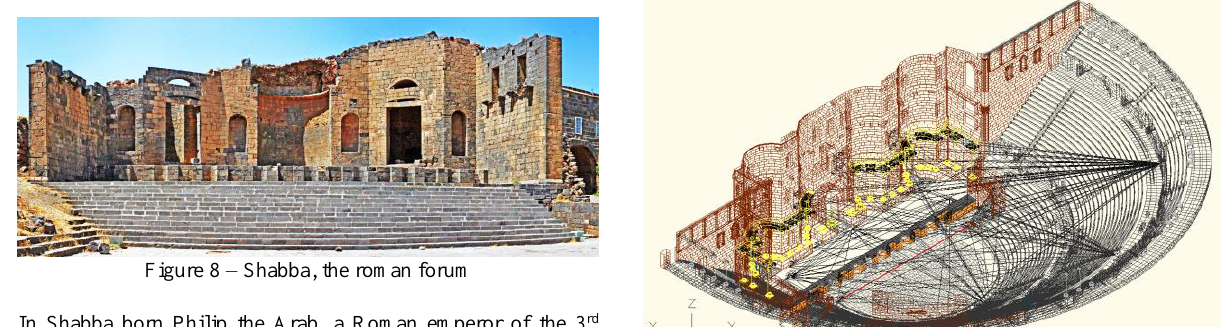
Figure 10 – Bosra, the Roman Theatre